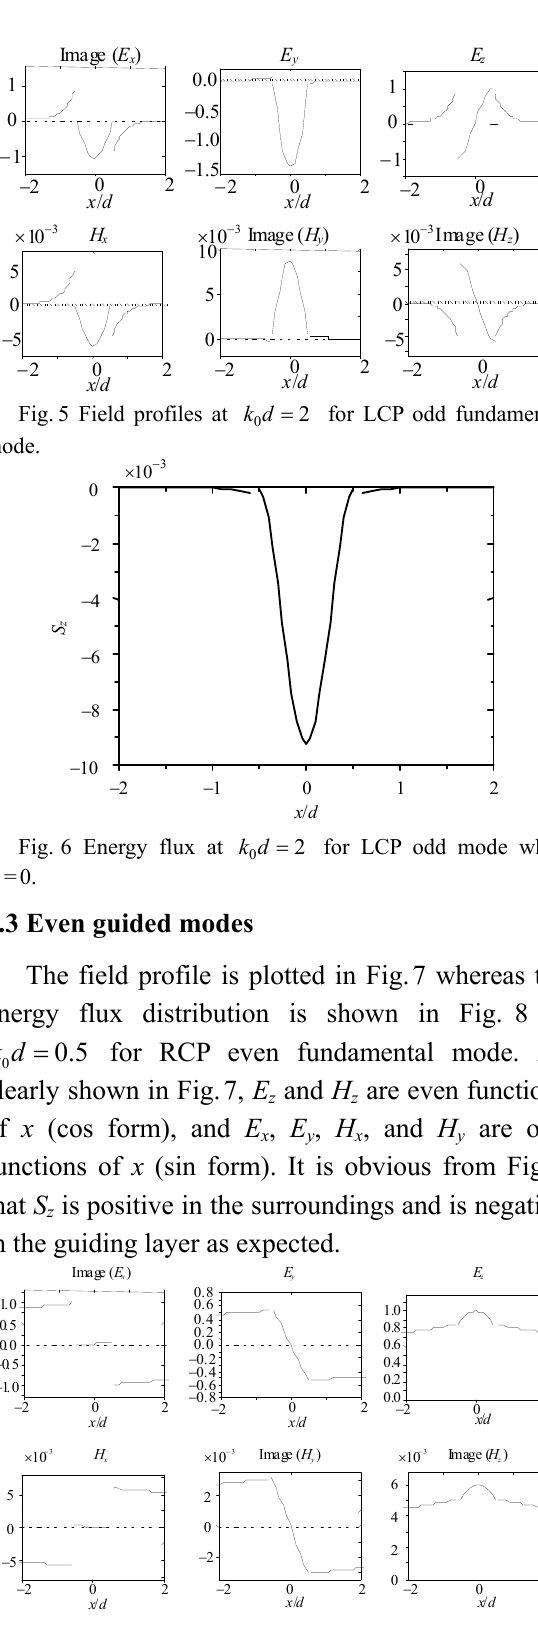
0.5 k d  for RCP even 0